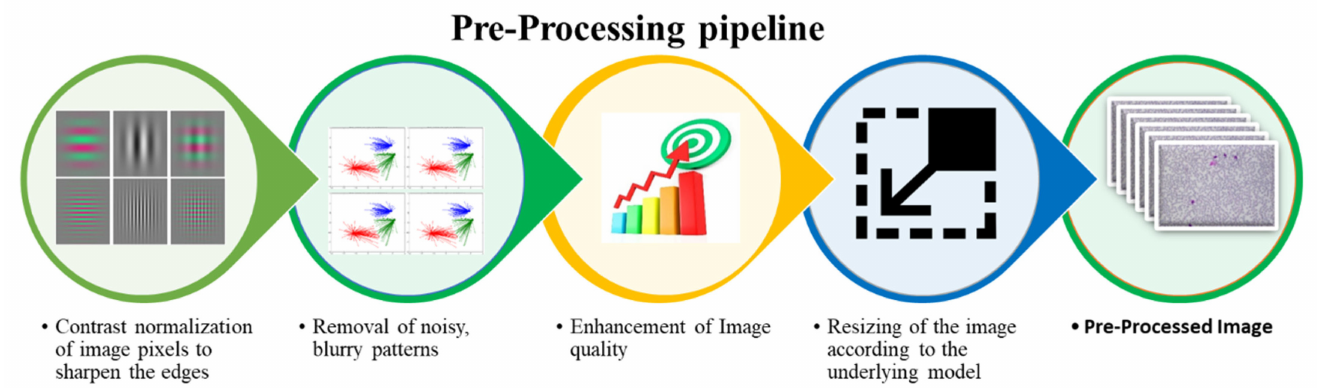
Figure 5. Pre-processing pipeline of the proposed model that applied to all images before initiation of the training